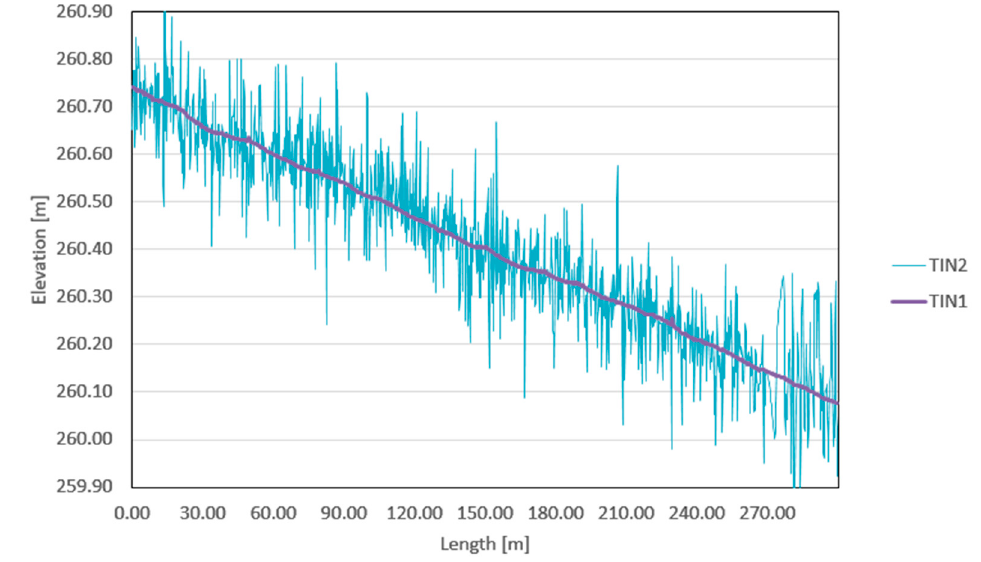
Figure 7. Modelling of the longitudinal section P3 using TIN interpolation methods.